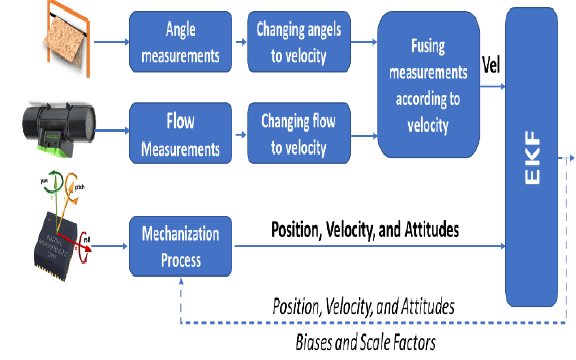
Figure 7. Proposed approach work scheme/integration through Extended Kalman